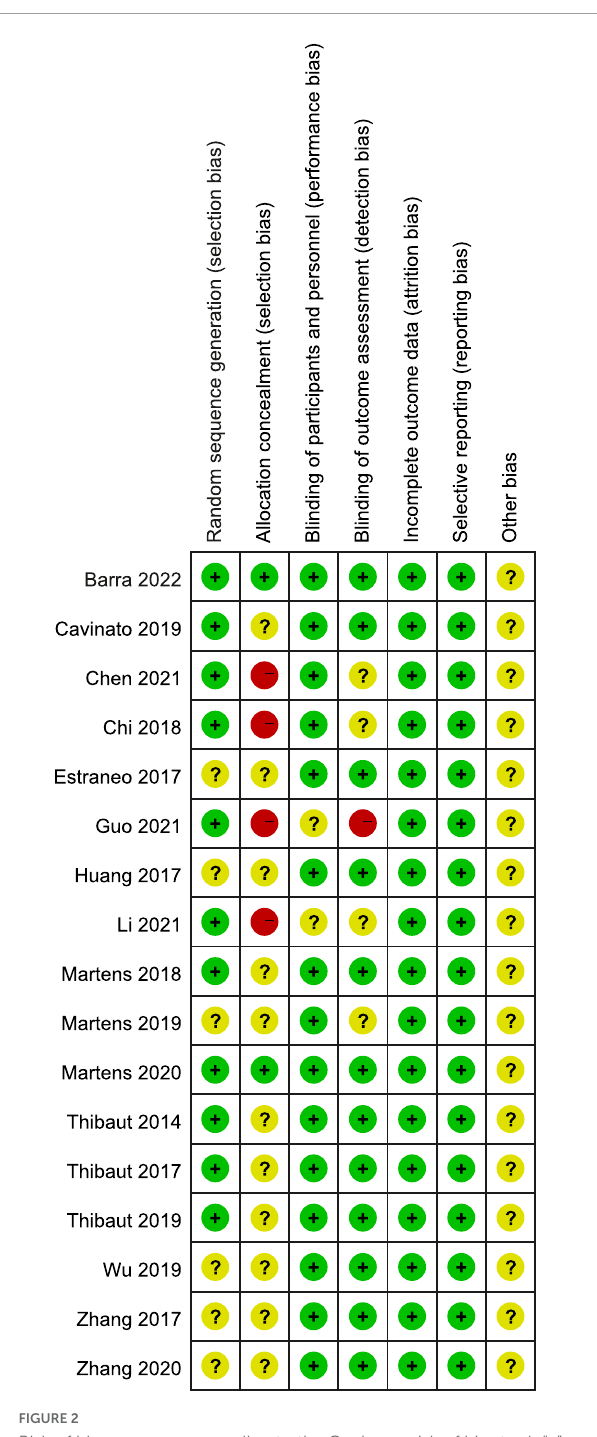
FIGURE2 Risk of bias summary according to the Cochrane risk of bias tool: “-”, “+”, and “?” indicate high, low, and unclear risk of bias, respectively.